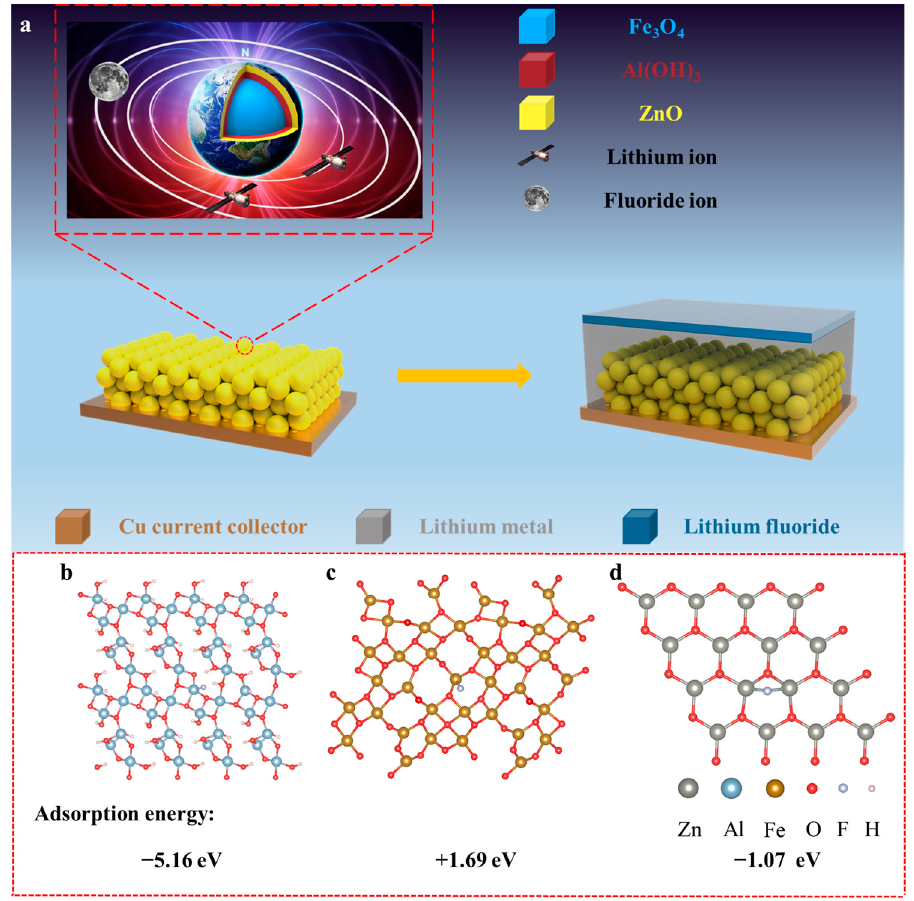
Figure 1. Mechanism introduction and first principles calculation. ( a ) Structure and mechanism of FAZ nanospheres. Adsorption model of ( b ) Al(OH) 3 and F − , ( c ) Fe 3 O 4 and F − , ( d ) ZnO and F − at top view.